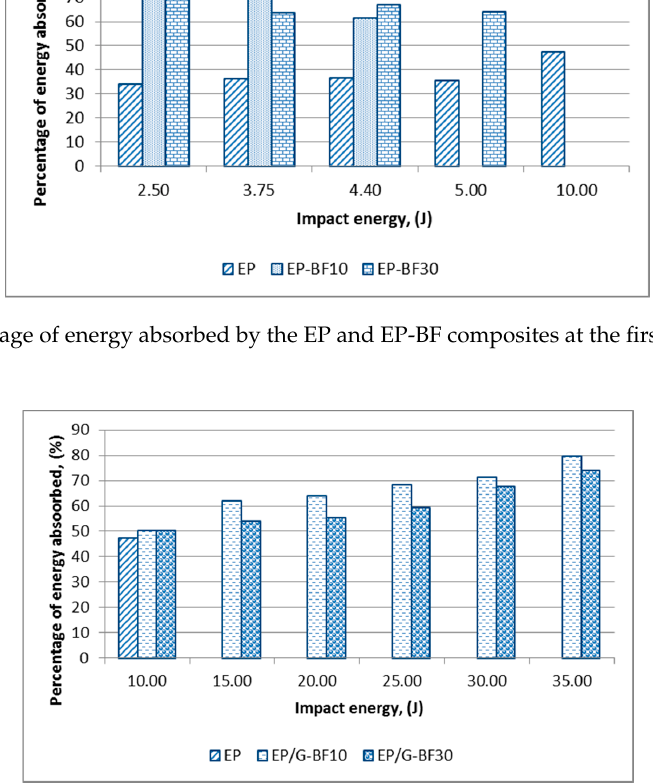
Figure 5. Percentage of energy absorbed by the EP and EP-BF composites at the first range of impact energy levels.